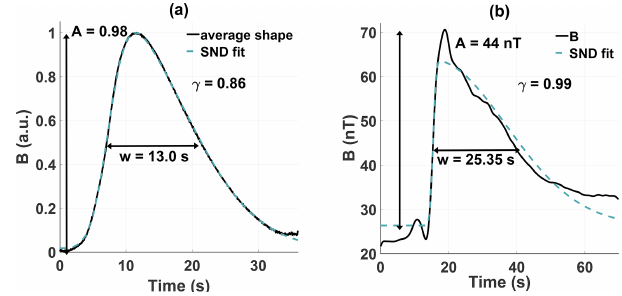
Figure 7. Skew normal distribution fitted to the average shape (a) and an exemplary wave (b) . Through the skew normal distribution, comprehensive definitions of amplitude, skewness and width are ob-